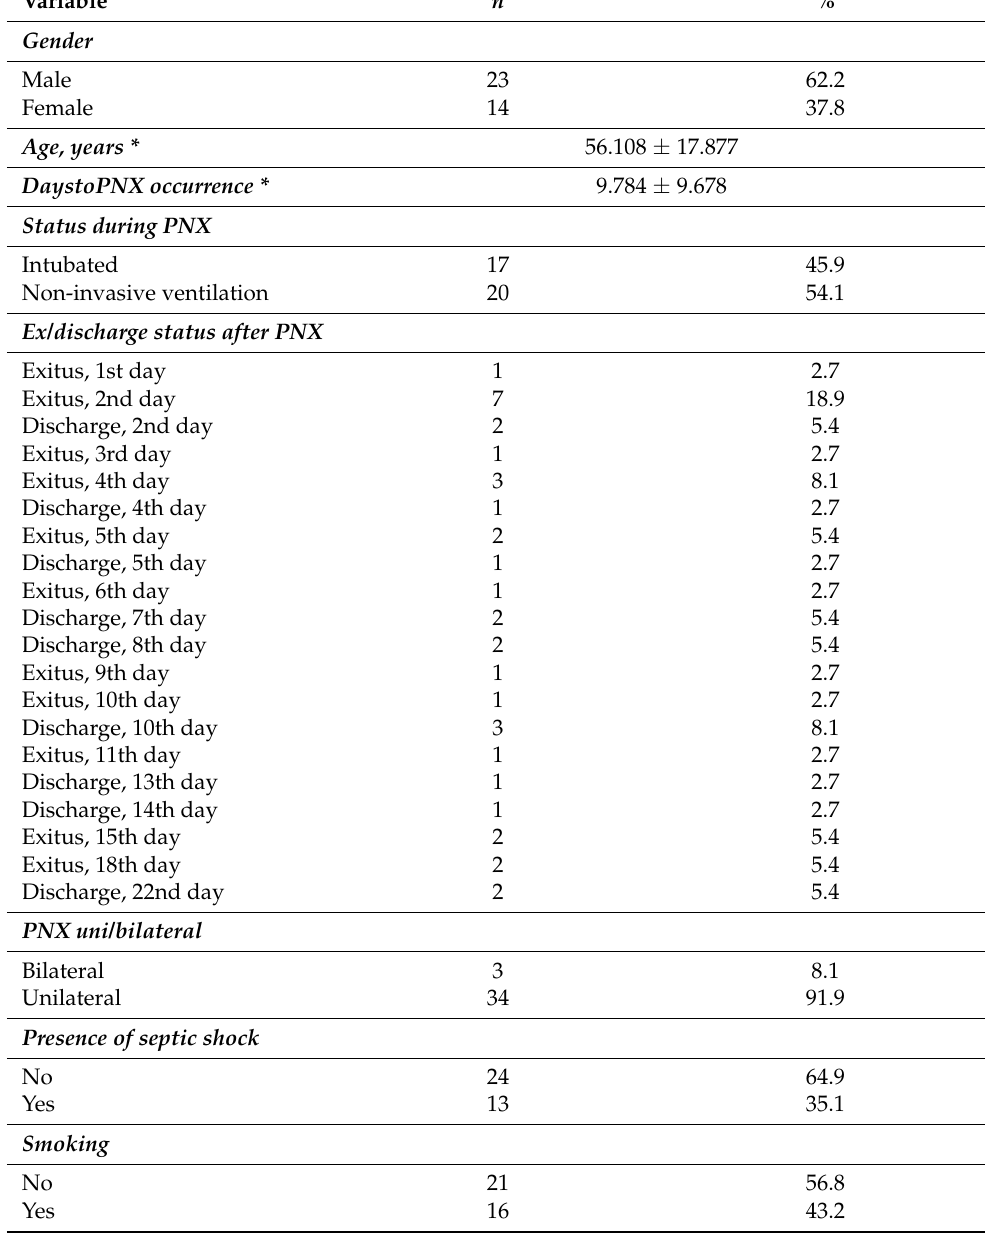
Table 1. Demographic characteristics of the patients and their distribution according to the pneu- mothorax (PNX) characteristics ( n